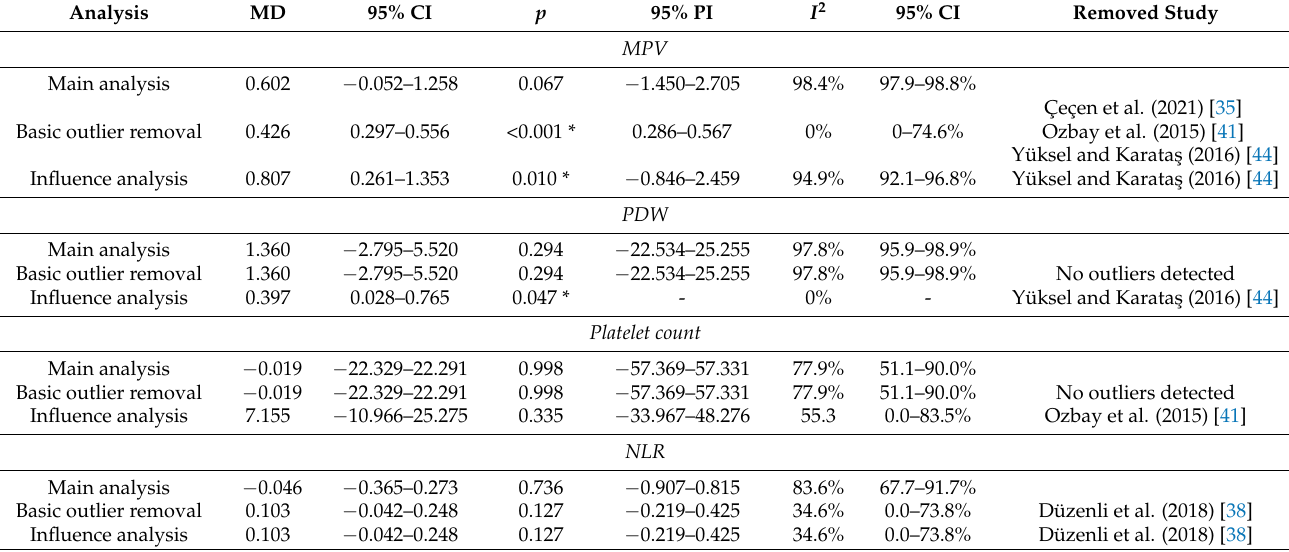
Table 3. Multiverse analysis of between-study heterogeneity assessment. MPV differences became sig- nificant after both outlier removal and influential study removal. PDW difference became significant after removal of an influential study. Significant values are marked with an asterisk